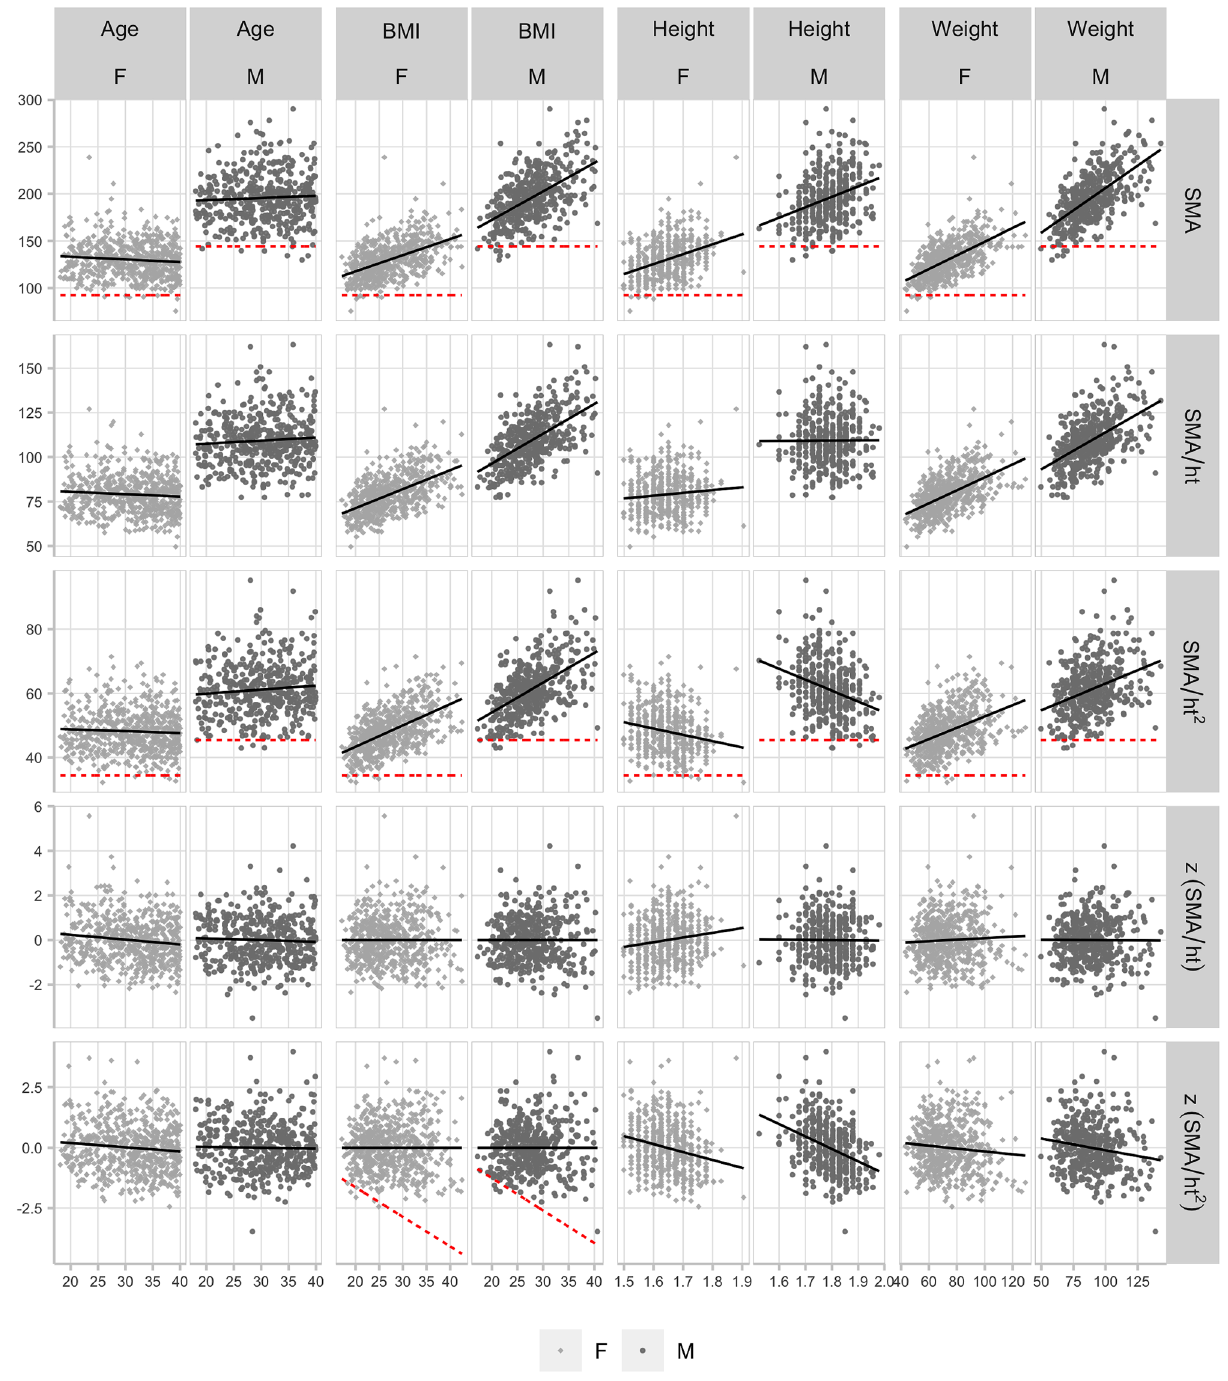
Figure 1. Under-40 cohort: scatter plots of L3 skeletal muscle area measures versus age, BMI, height, and weight, split by sex. Best-fit linear regression line overlaid (black, solid), and previously reported (Derstine, 2018) 15 sarcopenia ‘fixed’ cutoff values (red, dashed) where